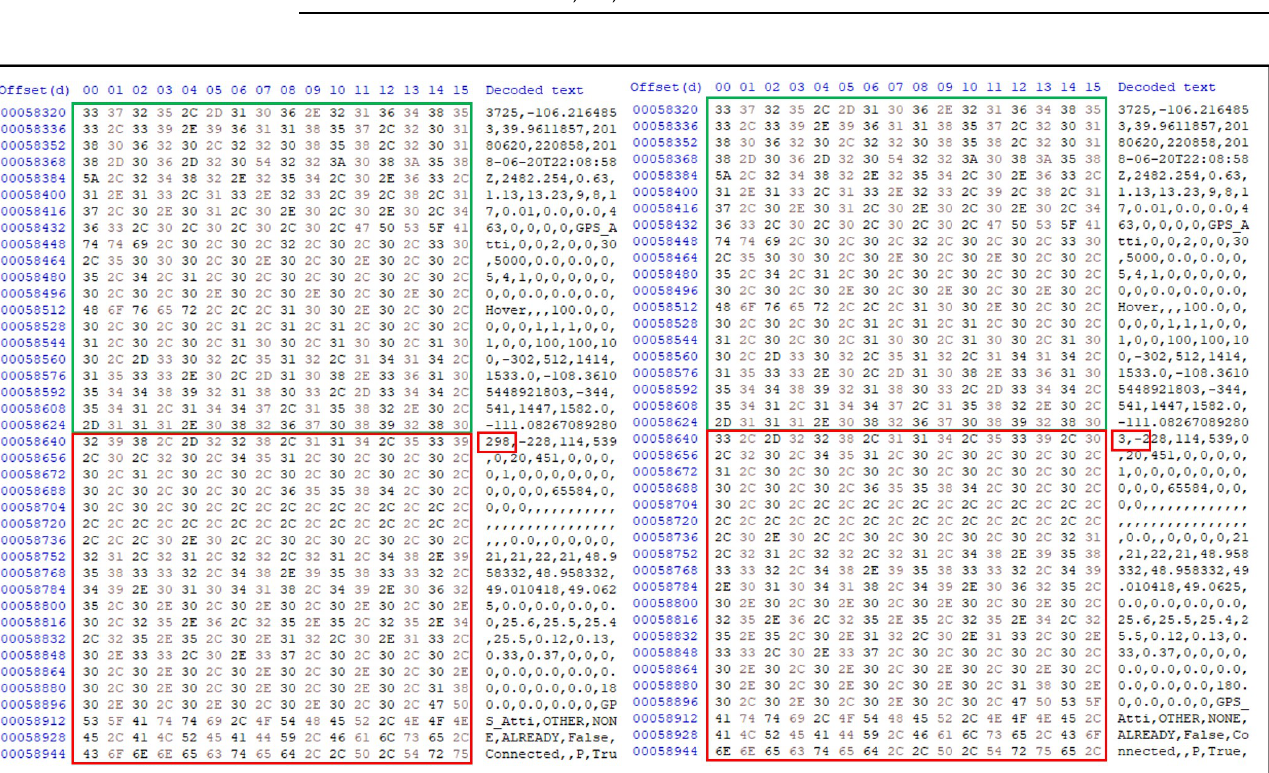
Figure 11. Data comparison analysis of the recovered flight log showing the beginning of byte